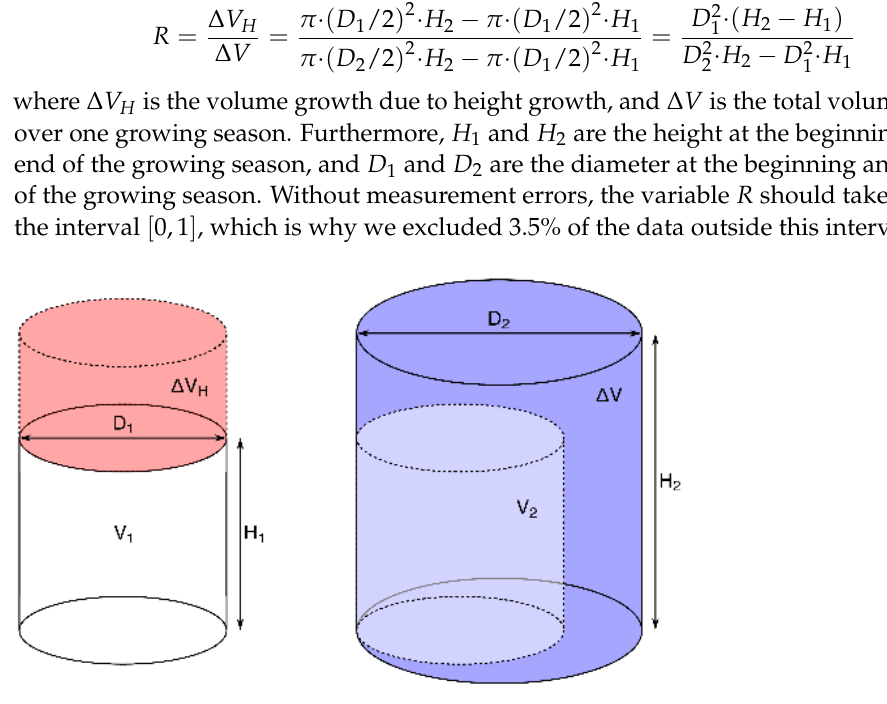
Figure 2. Visual representation of the cylindrical model for calculating the relative height volume growth ( R ), i.e., the share of the volume growth over one growing season attributed to height growth alone. ∆ V H is the volume growth due to height growth, ∆ V is the total volume growth over one growing season, H 1 and H 2 are the height at the beginning and the end of the growing season, and D 1 and D 2 are the diameter at the beginning and the end of the growing